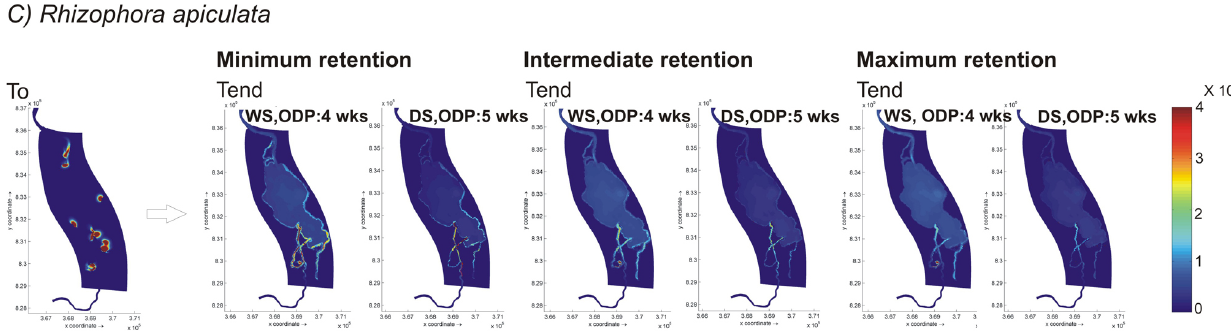
Fig. 5c. Results of scenario 1 (effect of species-specific buoyancy) showing the distribution plots of Rhizophora apiculata . WS = wet season, DS = dry season, ODP = obligated dispersal period. Red, yellow and light blue colours indicate a high, medium and low concentration of propagules